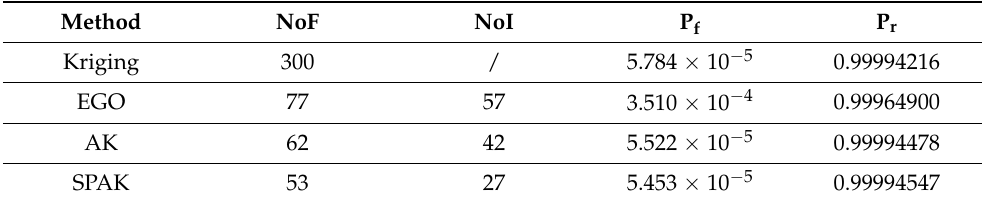
Table 6. Results of different methods of the